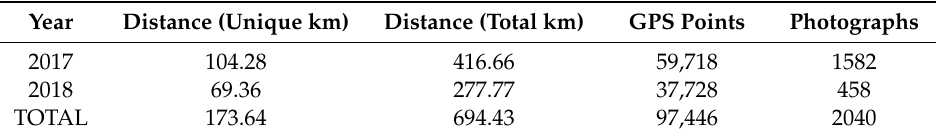
Table 1. A tabulated table of quantities mapped by Catch the King volunteers in coastal Virginia, USA, where the SCHISM-Driven Tidewatch storm tide model provided inundation